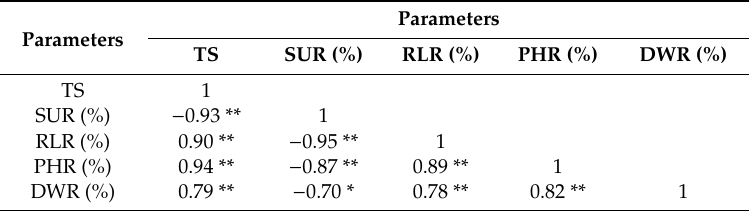
Table 6. Correlation matrix among tolerant